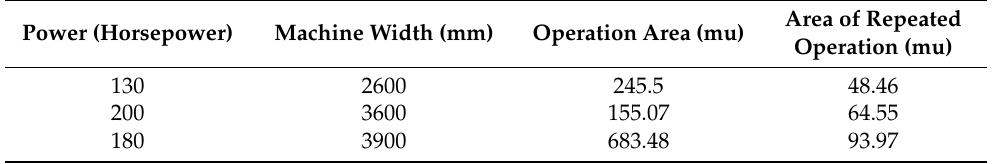
Table 4. Repeated operation of different types of agricultural machinery. Power